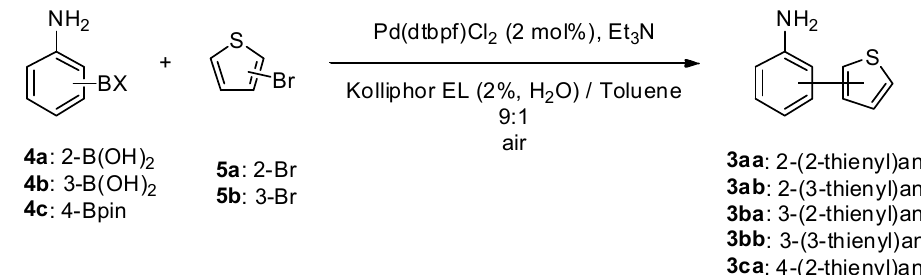
Organics 2021 , 2 , FOR PEER REVIEW